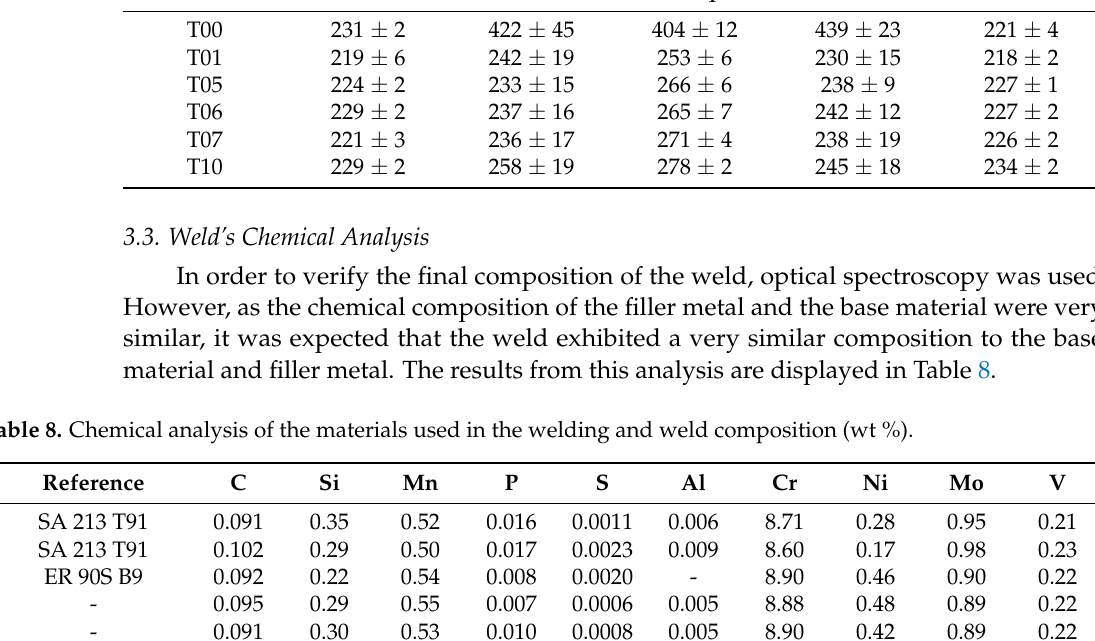
Table 7. Microhardness values for the cross-section of the differently treated welded samples. Sample Ref.